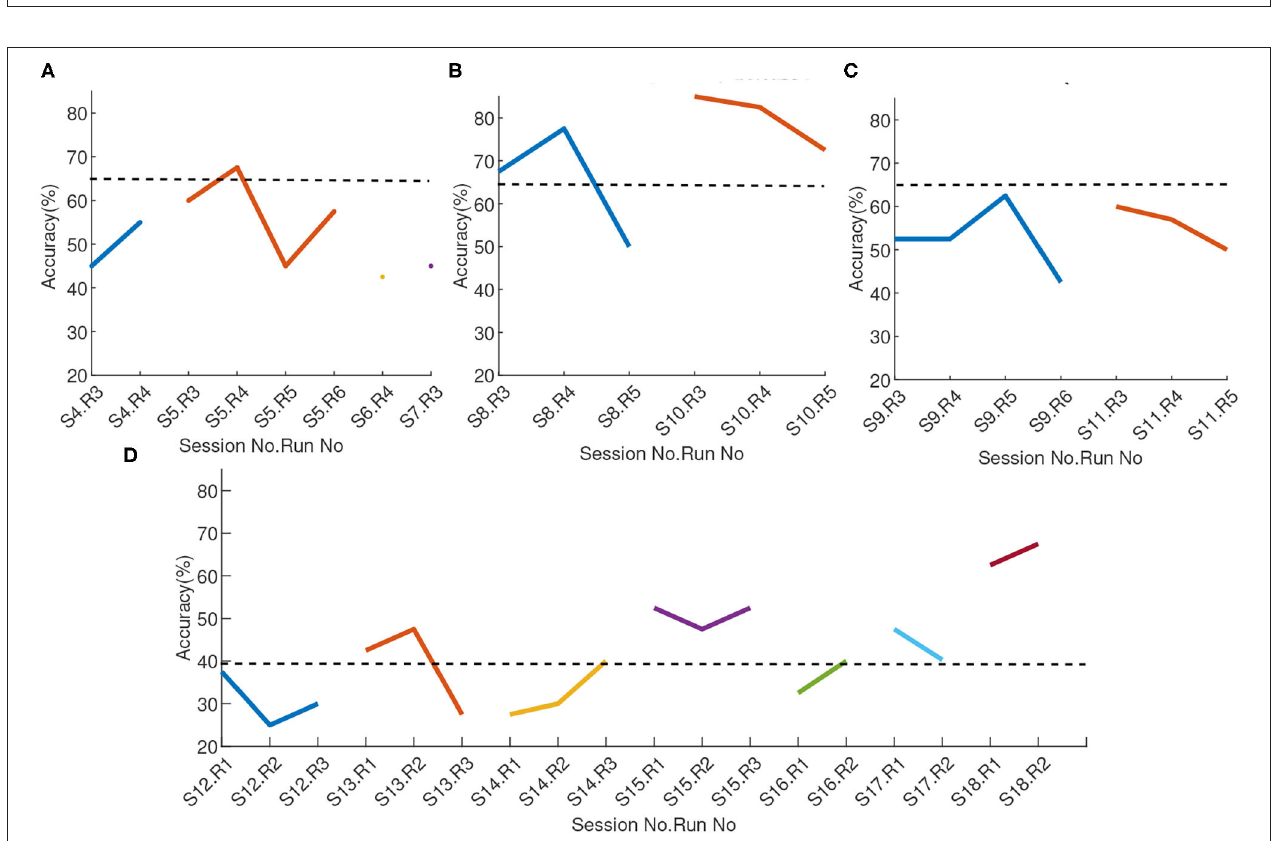
FIGURE 7 | Online classification accuracy across sessions and runs (A) Exploratory phase, (B) MENTAL-SUBTRACTION vs. REST of two-class training phase, (C) LEFT-HAND vs. RIGHT-HAND of two-class training phase, and (D) Transfer phase. Each point represent the accuracy of a run, different colors represent different sessions. The solid lines show the online accuracy and the dashed lines show the upper confidence limit of the chance-level at α = 0.05, according to Müller-Putz et al. (2008).